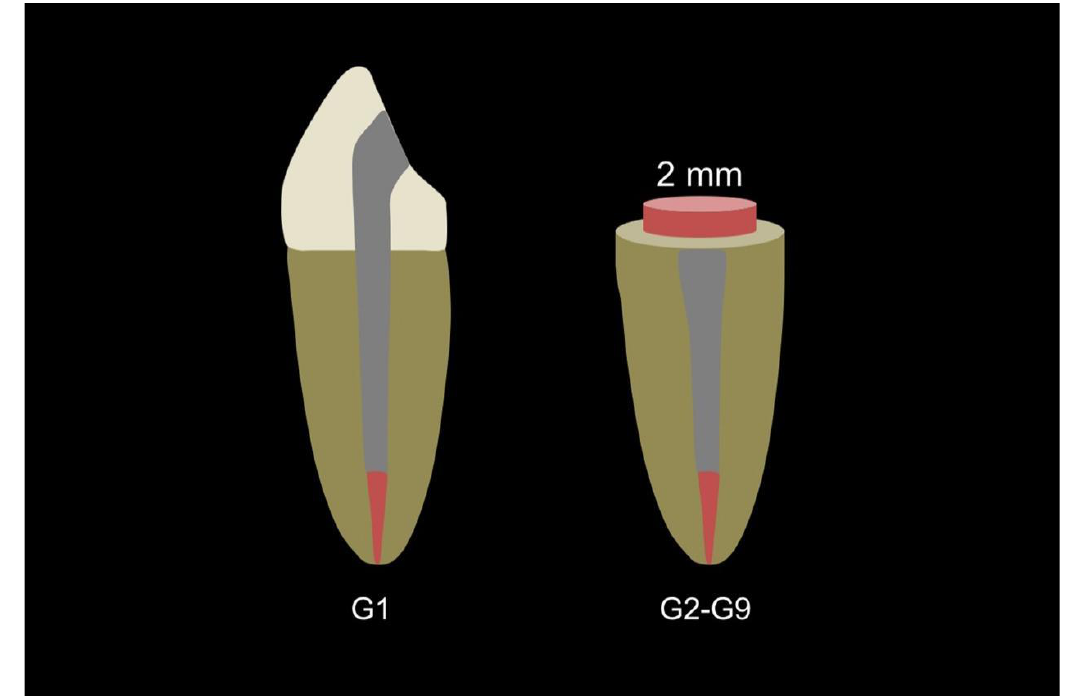
Figure 2. Control and experimental group